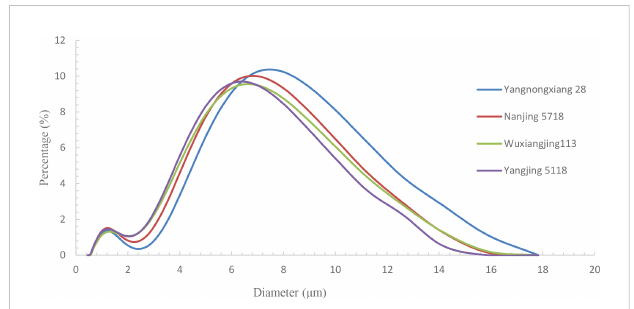
FIGURE 6 Starch grain size distribution of the four soft rice